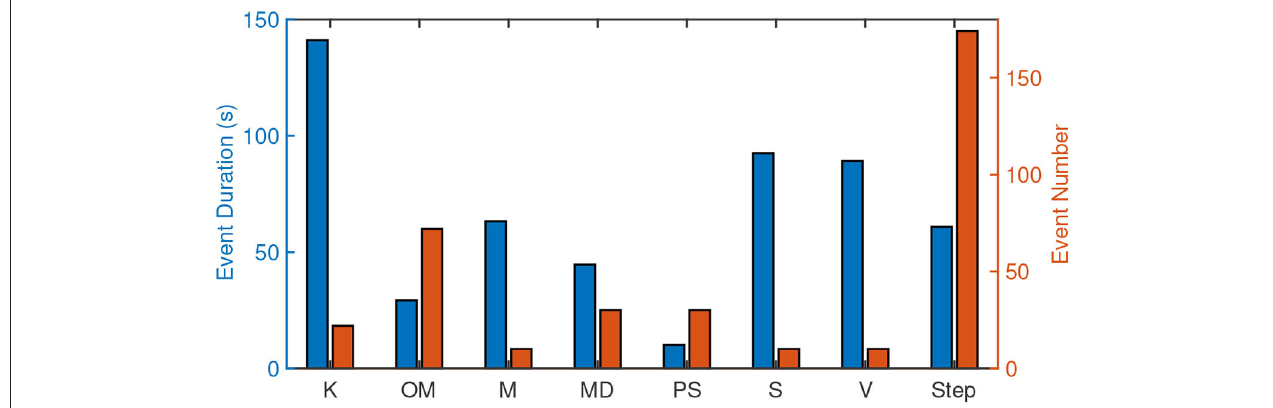
FIGURE 8 | Experiment data